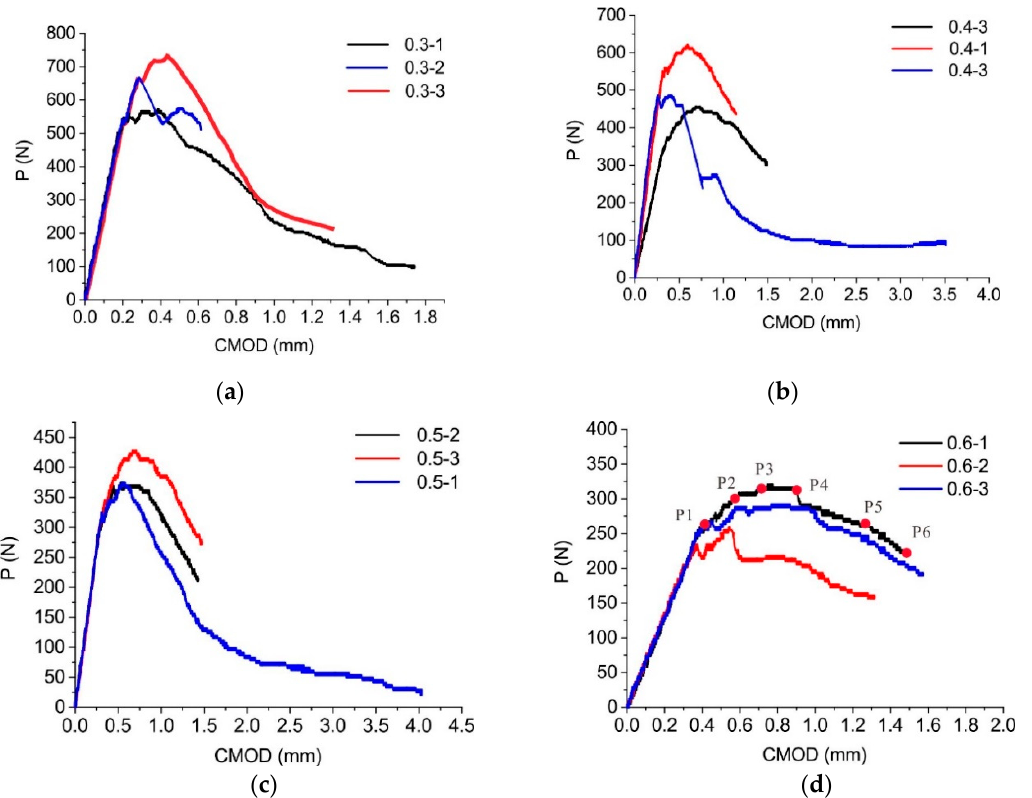
Figure 5. The experimental curves P -CMOD of the four group specimens. ( a ) a 0 / d =0.3, ( b ) a 0 / d =0.4, ( c ) a 0 / d = 0.5, ( d ) a 0 / d = 0.6.